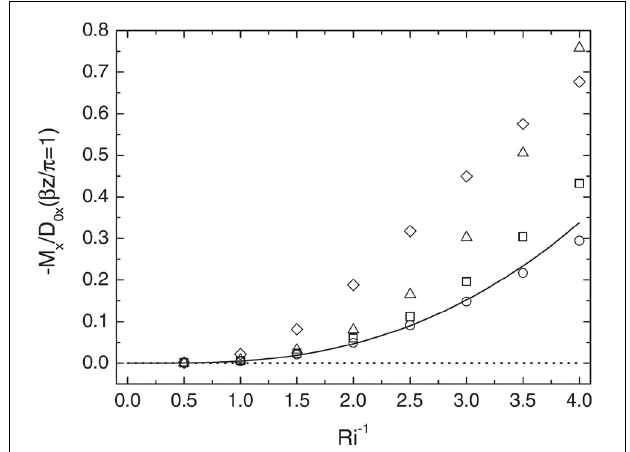
FIGURE 7 | Normalized momentum flux at the height β z /π = 1 as a function of Ri for the wind profile (41). Solid line: (54), dashed line: Ri (cid:11) 1 limit (total absorption), symbols: numerical simulations for different values of ˜ h : circles: 0.01, squares: 0.1, triangles: 0.2, diamonds: 0.5. Reproduced from Figure 5 Teixeira and Miranda of [85]. © American Meteorological Society. Used with